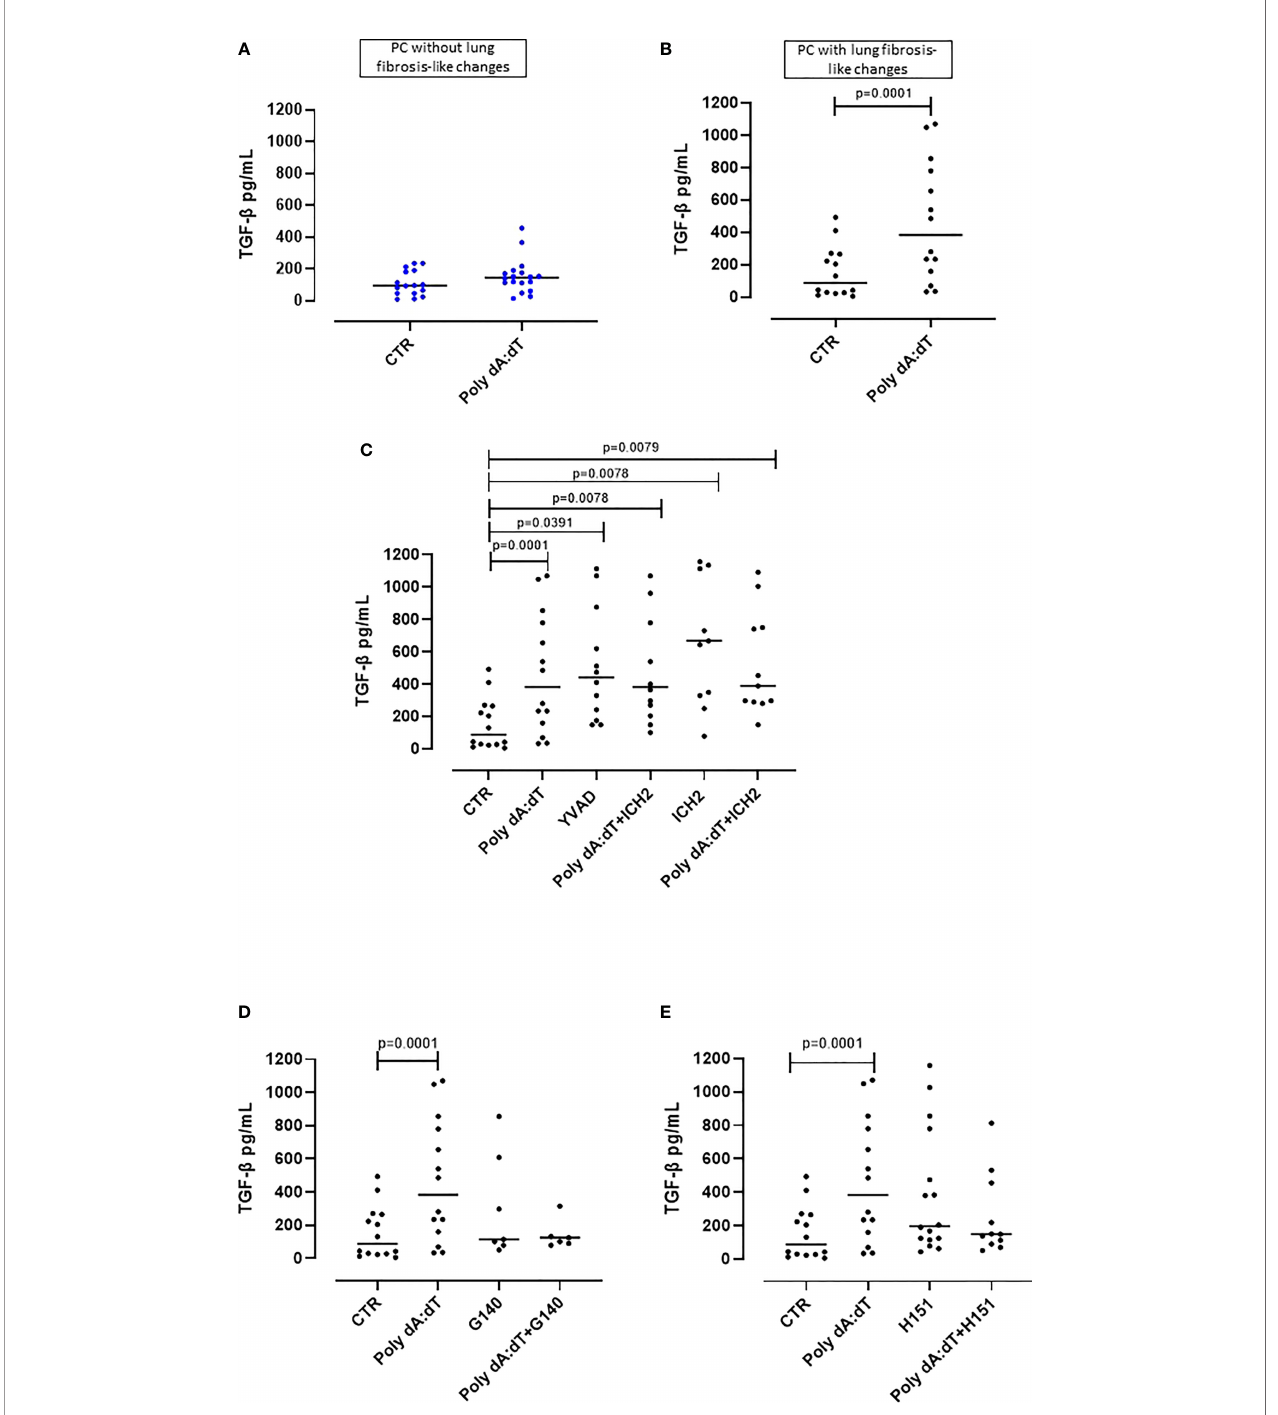
FIGURE 4 | AIM2 receptor activation induced pro- fi brotic TGF- b release from PBMCs from Post-COVID-19 patients with fi brosis. (A) Stimulation of AIM2 in PBMCs from Post-COVID-19 (PC) patients without signs of fi brosis did not increase the release of TGF- b . (B) In stark contrast, stimulation of AIM2 in PBMCs from Post- COVID-19 (PC) patients with signs of fi brosis substantially increased the release of TGF- b levels. (C) Inhibition of caspase-1 and caspase-4 with Ac-YVAD-cmk (YVAD, 1 m g/mL) and ICH2 (ICH2, 6,4 m g/ml), respectively, did not reduce the release of TGF- b after Poly dA:dT stimulation. (D) Inhibition of cGAS or (E) STING with G140 (2 m g/ml) and H-151 (H151, 1 m g/mL), did not reduce the release of TGF- b after Poly dA:dT stimulation. Data are reported as median and represented as scatter dot plots. Statistical analysis was performed using the Wilcoxon matched-pairs signed rank